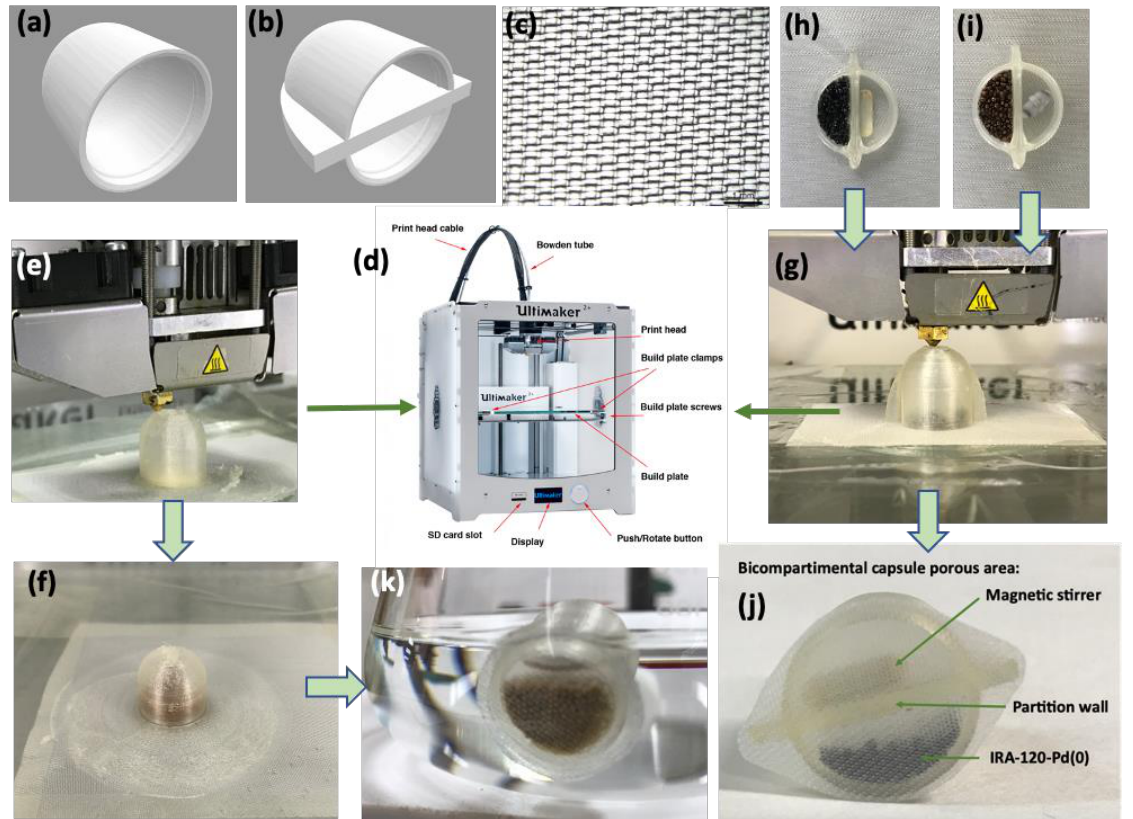
Figure 2. ( a ) The 3D design of a unicompartmental capsule (see also Figure S1); ( b ) bicompartmental capsule; ( c ) polypropylene mesh (bar scale 1 mm); ( d ) 3D printer and components; ( e,f ) 3D